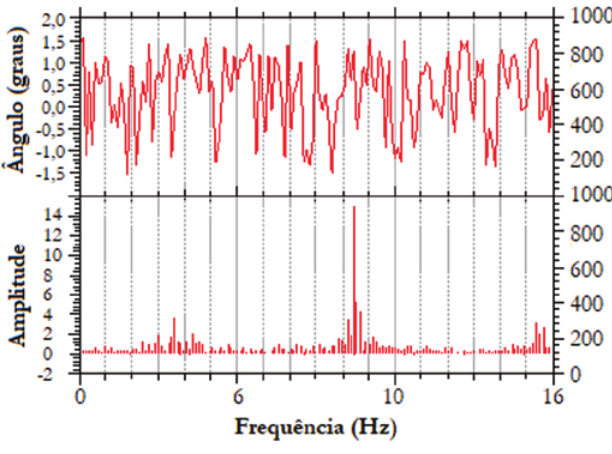
Deslocamento do vértice superior esquerdo